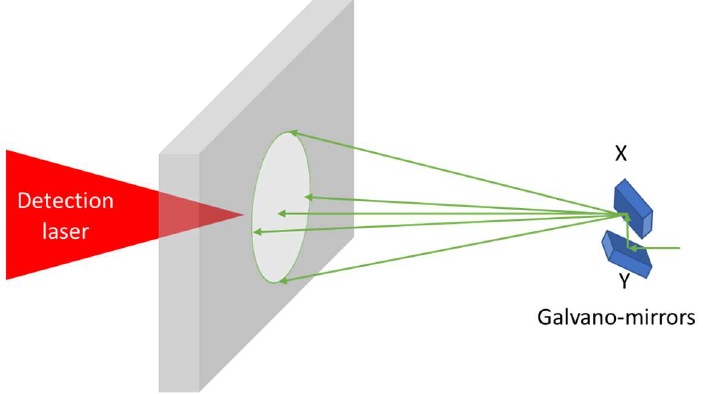
Figure 4. Schematic of the laser ultrasonic transmission measurement set-up, generating on one side and detecting on the opposite side. The Galvano mirrors can direct the generation point and the position is measured synchronously with the ultrasonic response. The detection and generating lasers are focused on opposite sides of the specimen.